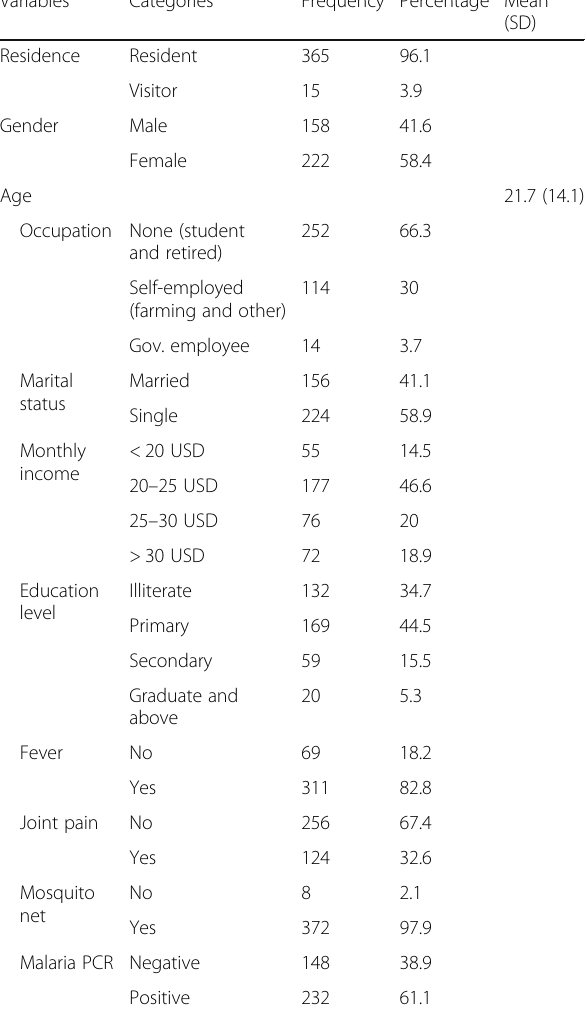
Table 1 General and socio-demographic characteristics